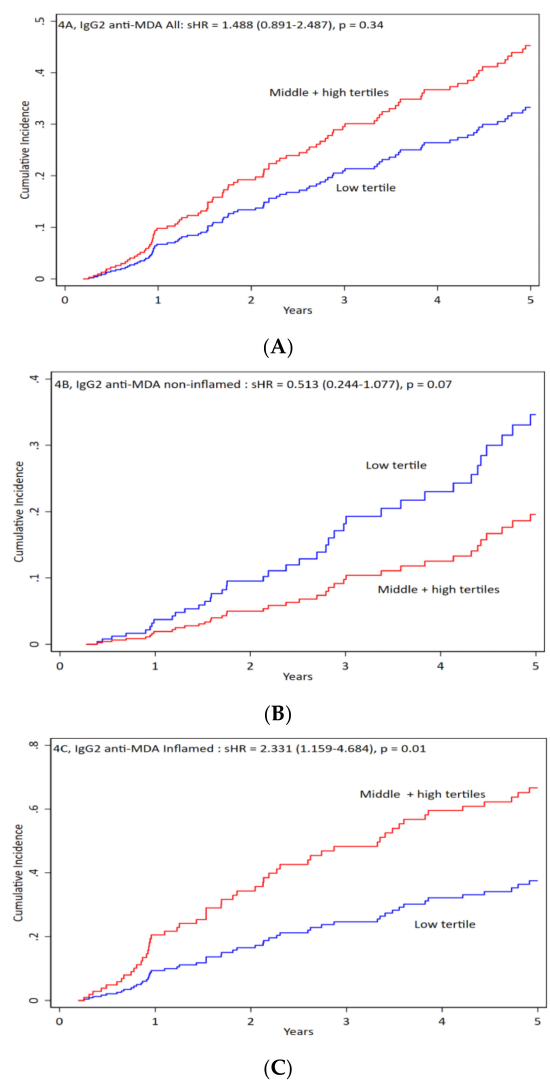
Figure 4. IgG2 anti-MDA impact on the mortality of all patients and inflamed versus non-inflamed. Patients were divided into three groups: ( A ) for all patients, ( B ) for non-inflamed patients, and ( C ) for inflamed patients. Antibody levels were divided into low vs. middle + high levels of IgG2 antibodies against malondialdehyde (anti-MDA) for cumulative incidence vs. time. For all patients the sHR is 1.488 (0.891–2.487), p = 0.34. For non-inflamed patients the sHR is 0.513 (0.244–1.077), p = 0.07. For inflamed patients the sHR is 2.331 (1.159–4.684), p =